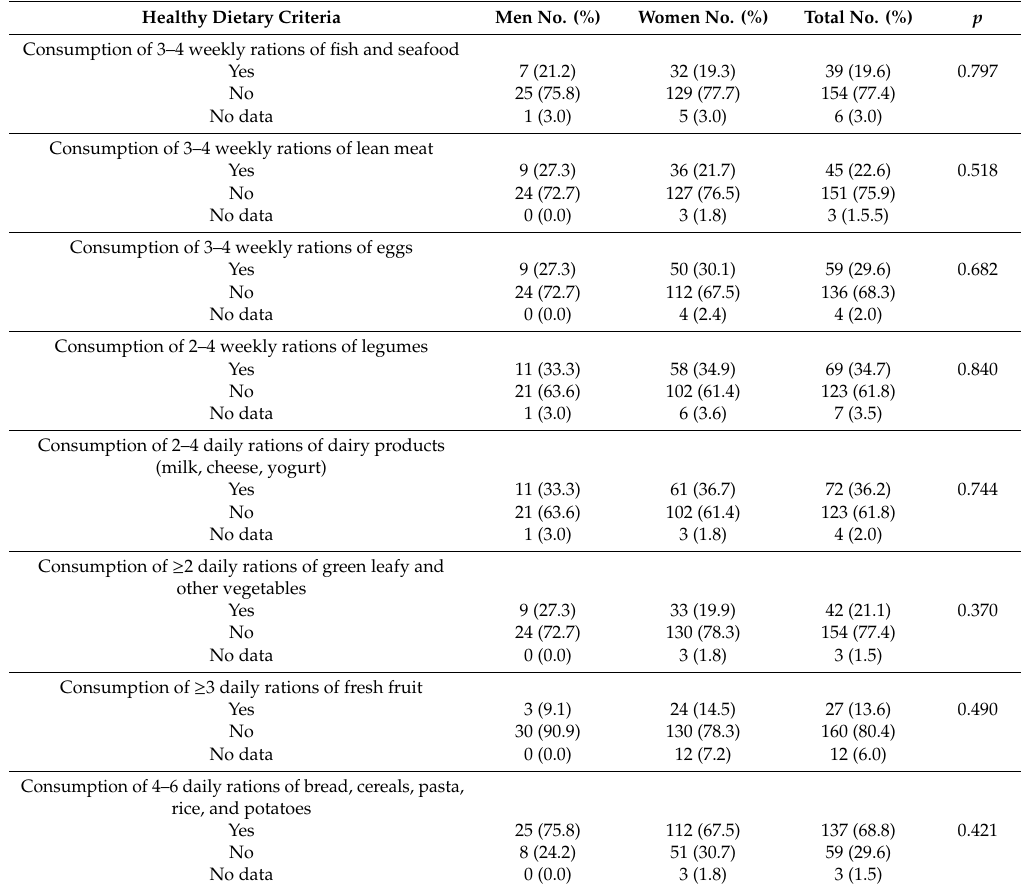
Table 3. Description of compliance with healthy dietary criteria among the